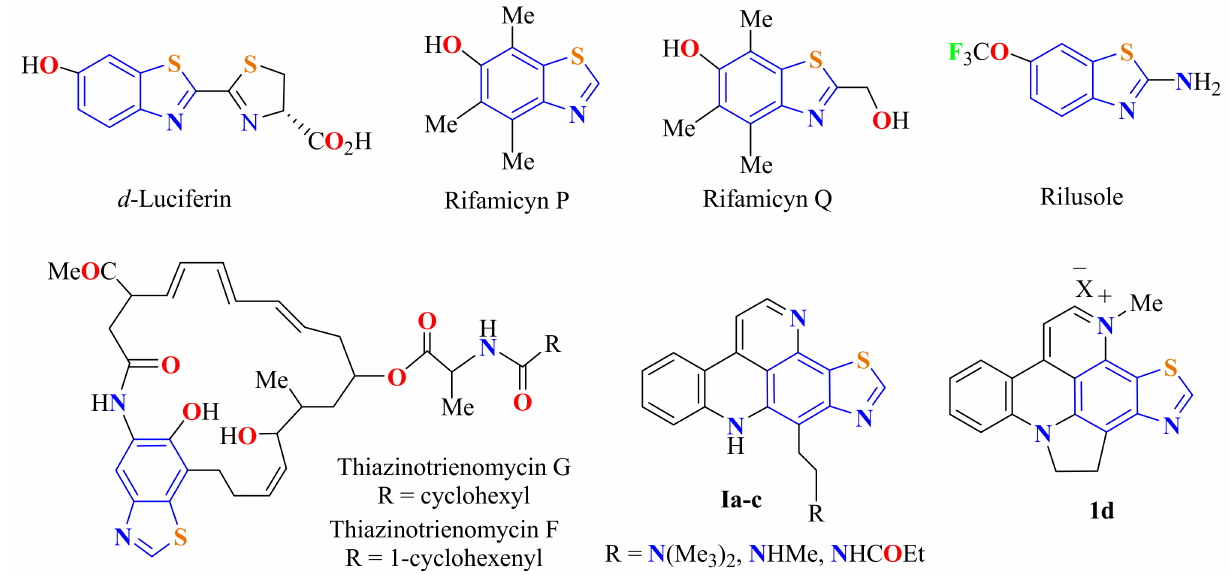
Figure 2. Benzothiazole derivative compounds found in natural